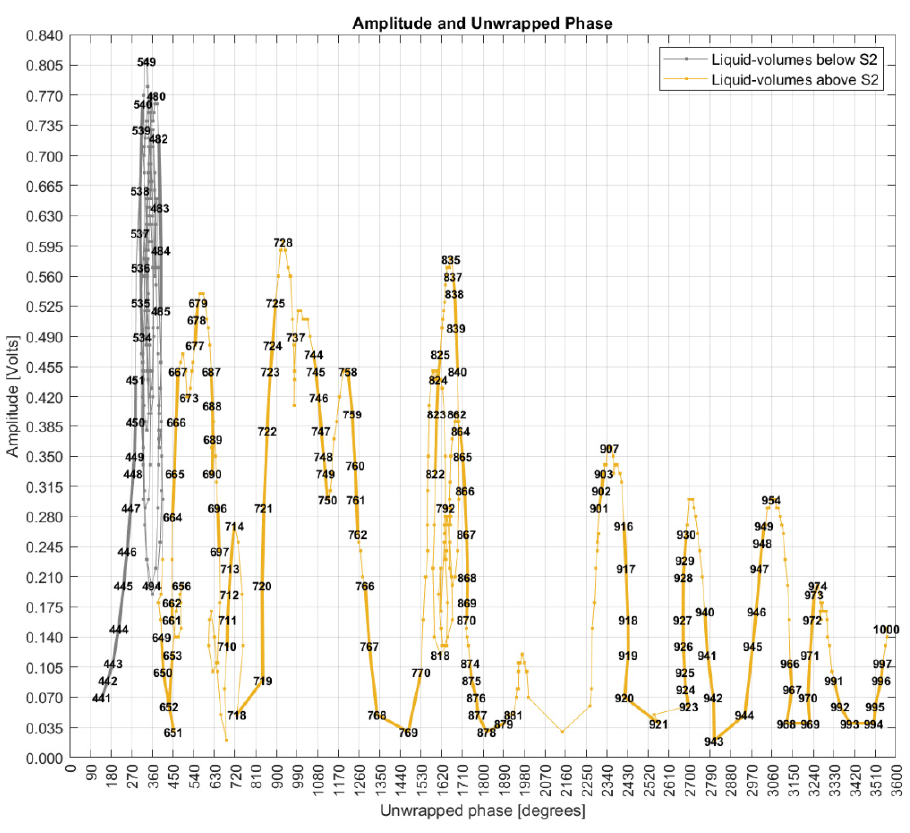
Figure 17. The 2D grade of amplitudes and unwrapped phases (after action “c” is applied).